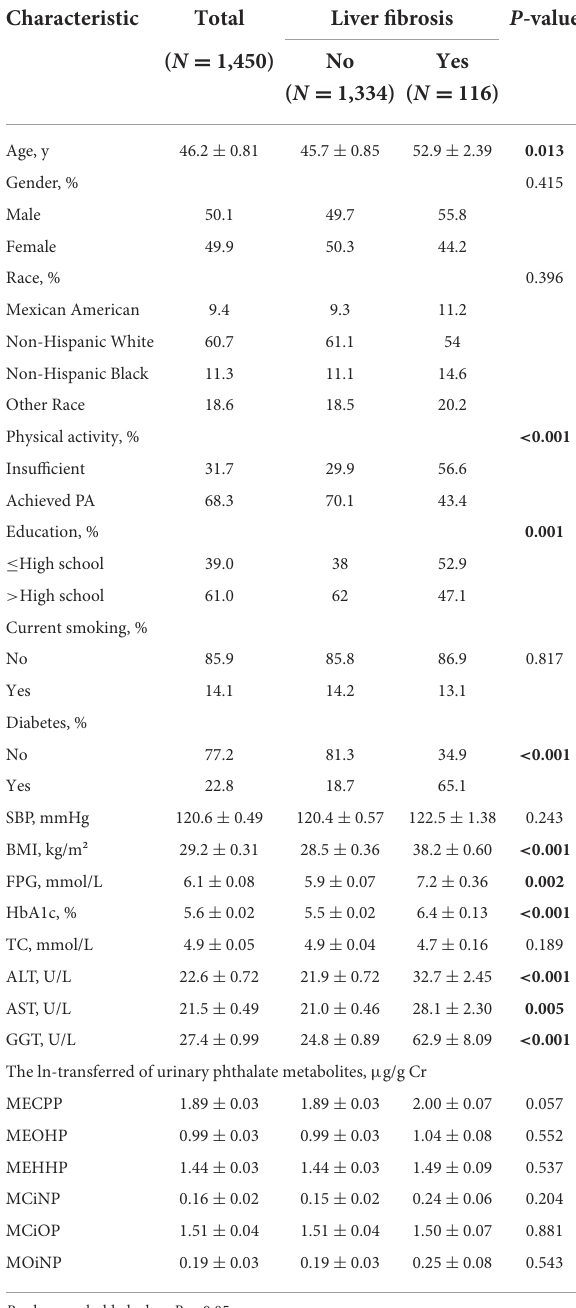
TABLE 2 Population characteristics of American adults with or without liver fibrosis from NHANES 2017–2018. Characteristic Total Liver fibrosis P -value